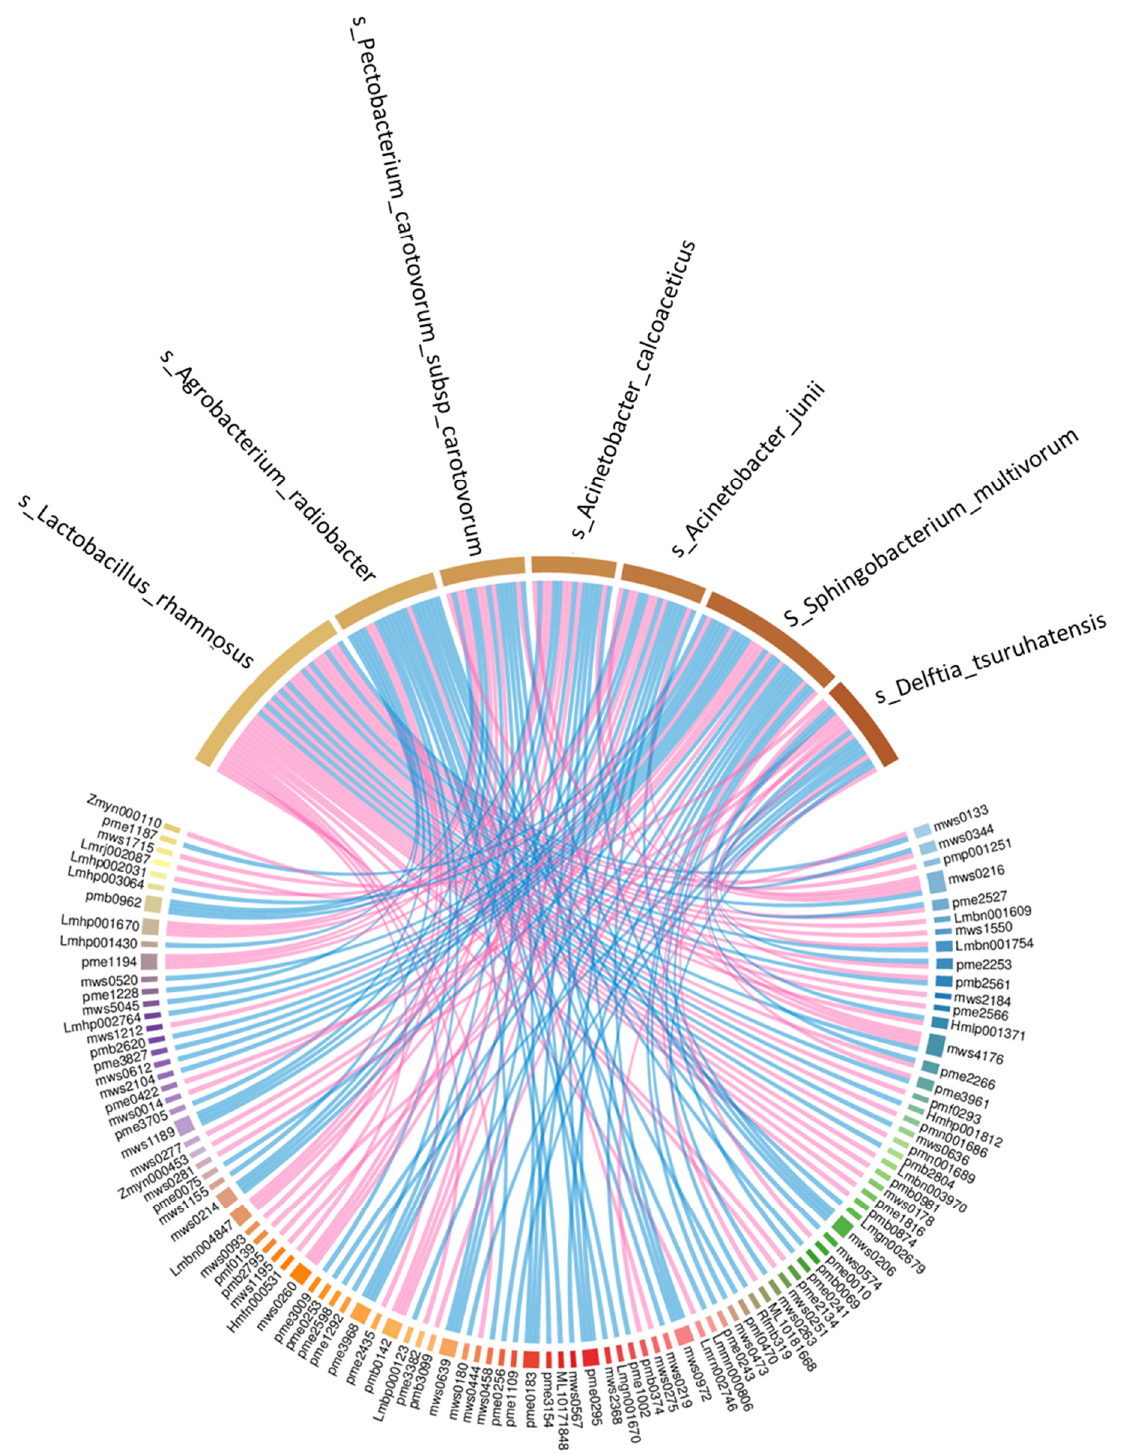
Figure 10. Chord network diagram of the correlation between dominant bacterial species and signifi- cant metabolites (The width of the string connection represents the size of the correlation between the two variables connected, and the wider the link, the greater the absolute value of the correlation while, pink string indicates a positive correlation and blue indicates a negative